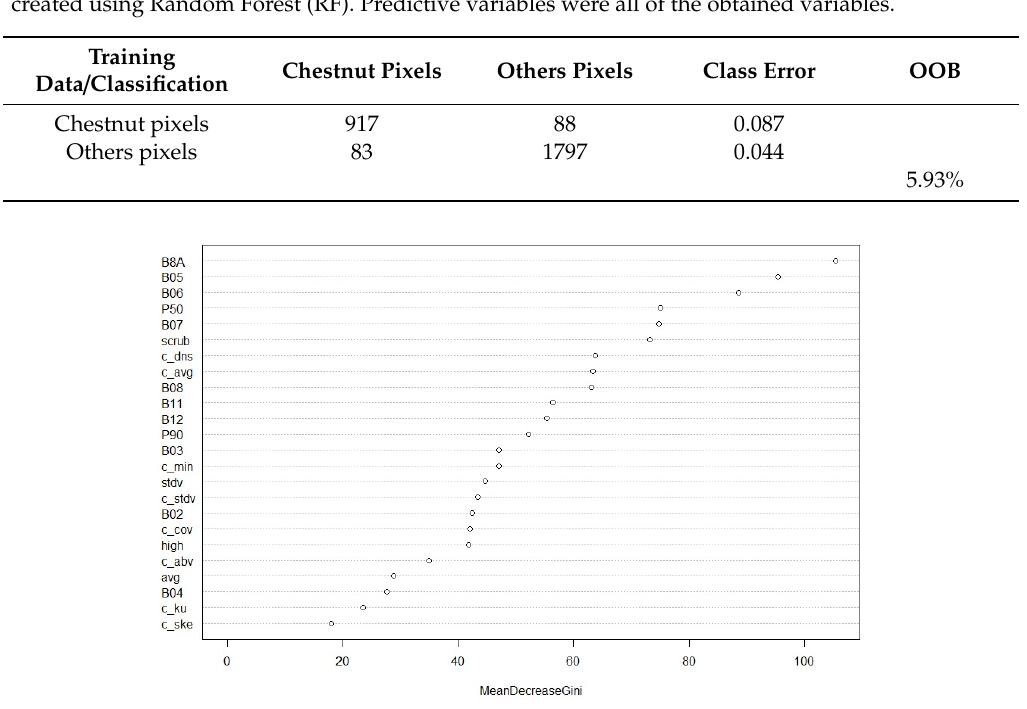
Table 4. Training data classification results for Model 2, including the out-of-bag (OOB) error. Model created using RF. Predictive variables, variables selected by the selection algorithm (VSURF).